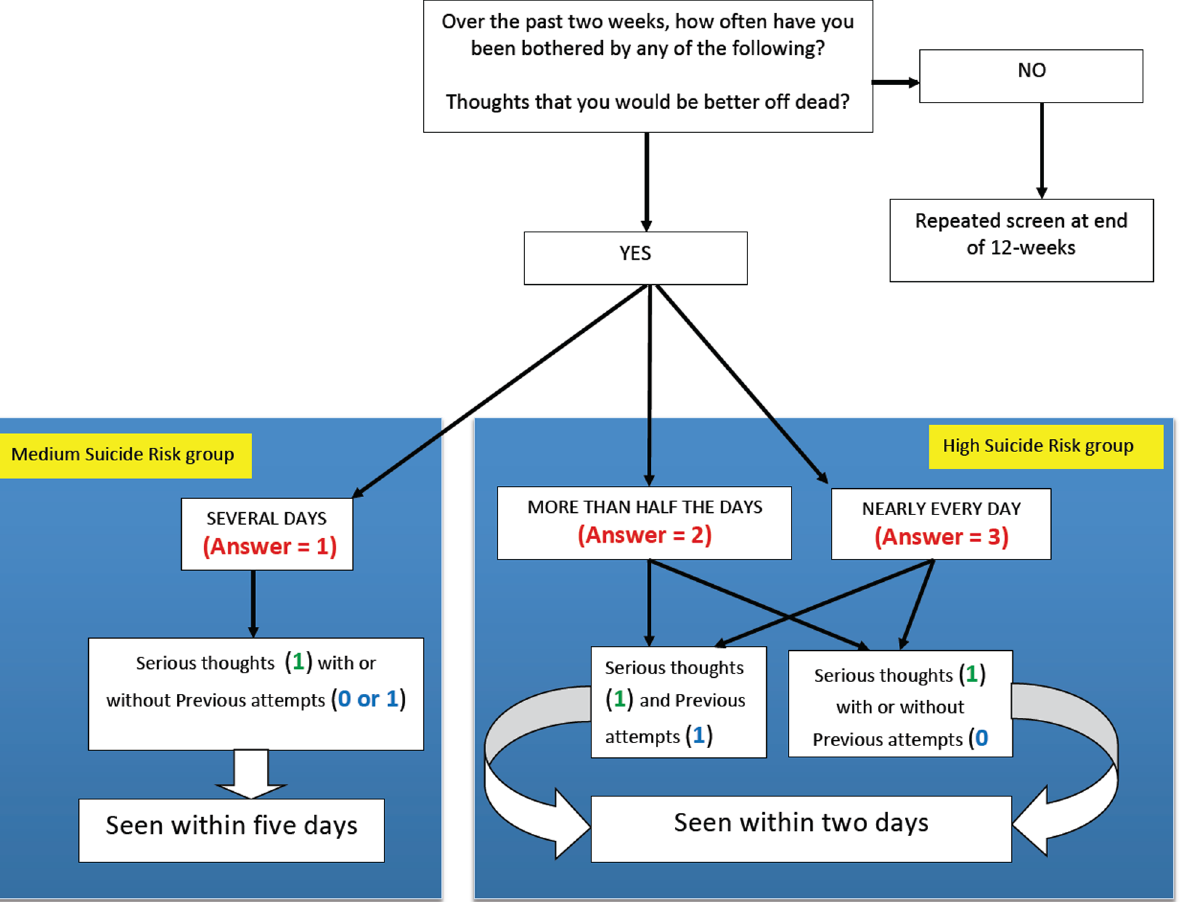
Fig 2. Algorithm for determining which students were in the “ actively suicidal ” group. The figure shows how scores on the three questions regarding suicide risk determined if the student was in the high suicide risk group or the medium suicide risk group. Together, these students were considered the “ actively suicidal" group, and were interviewed individually within 2 days for the high suicide risk group or within 5 days for the medium suicide risk